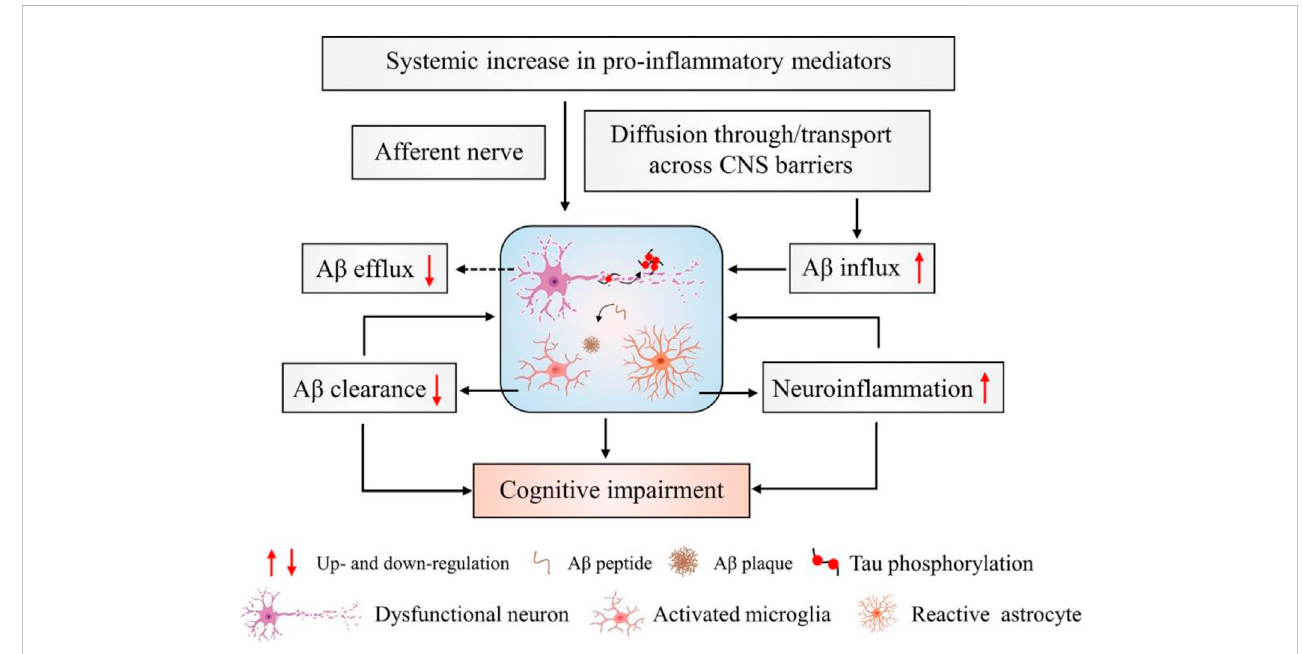
FIGURE 1 In fl ammation and neurophysiology from AD. During the development and progression of AD, amyloid plaques activate microglia and astrocyte cells. These activated microglia increase the expression of in fl ammatory mediators such as interleukins, TNF- α , cytokines, etc., and enhance neuroin fl ammation. Thus, decreased A β clearance and increased neuroin fl ammation are responsible for cognitive impairment in